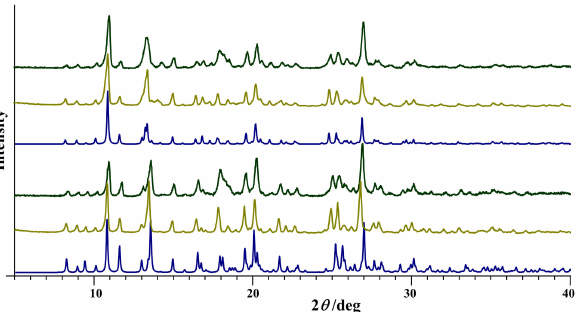
Figure 1. PXRD patterns of [1H]Cl · 0.5VA (the three powder patterns on the top) and [1H]Br · 0.5VA (the three powder patterns on the bottom) obtained by the mechanochemical method (the dark green lines) and solution-based method (the olive lines). The blue lines indicate patterns calculated from the X-ray single-crystal structures of the corresponding